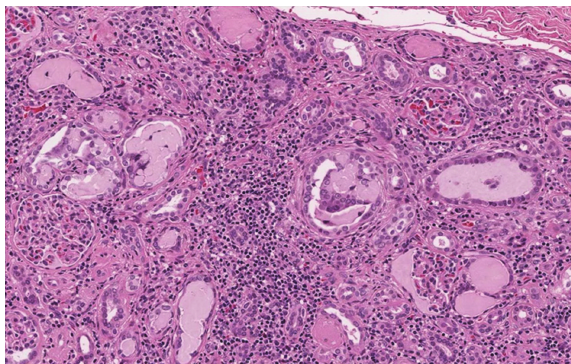
Figure 2: Histopathological